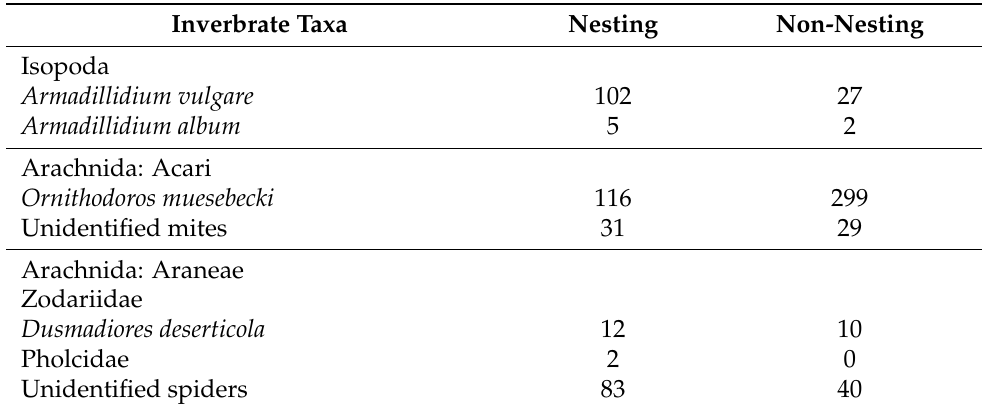
Table 1. Invertebrates collected from inside and outside nesting areas on Siniya Island, Umm Al Quwain, United Arab